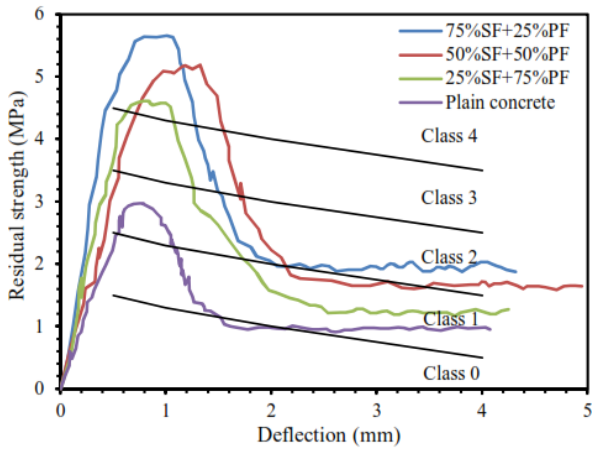
Figure 15: Residual Classification of flexural strength for HFRC in accordance with